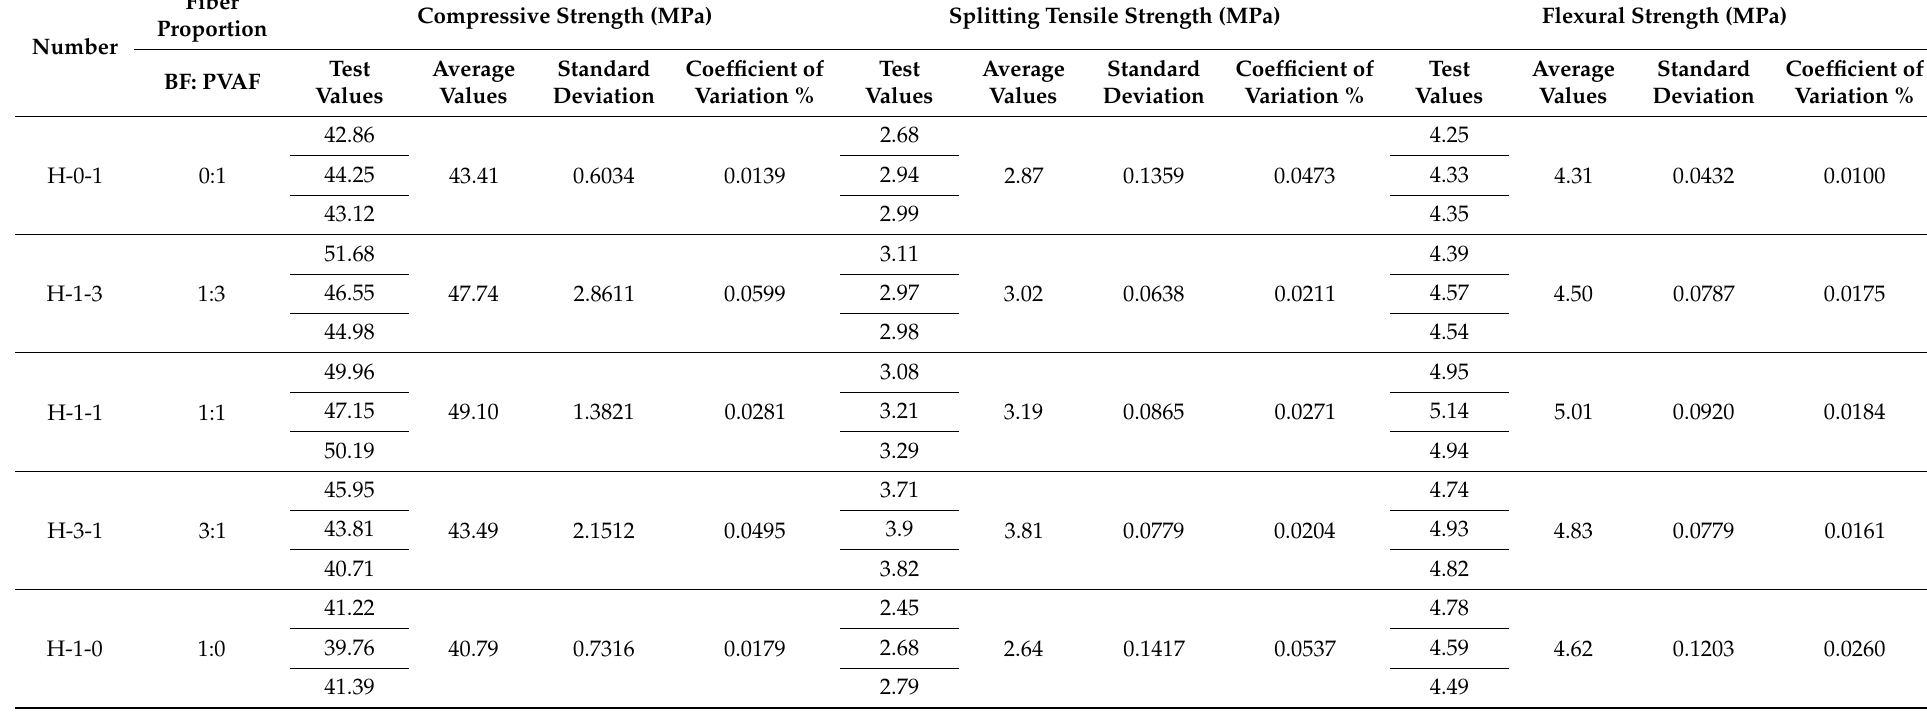
Table 10. Basic mechanical properties of LHPCC with different fiber hybrid ratios (total fiber content: